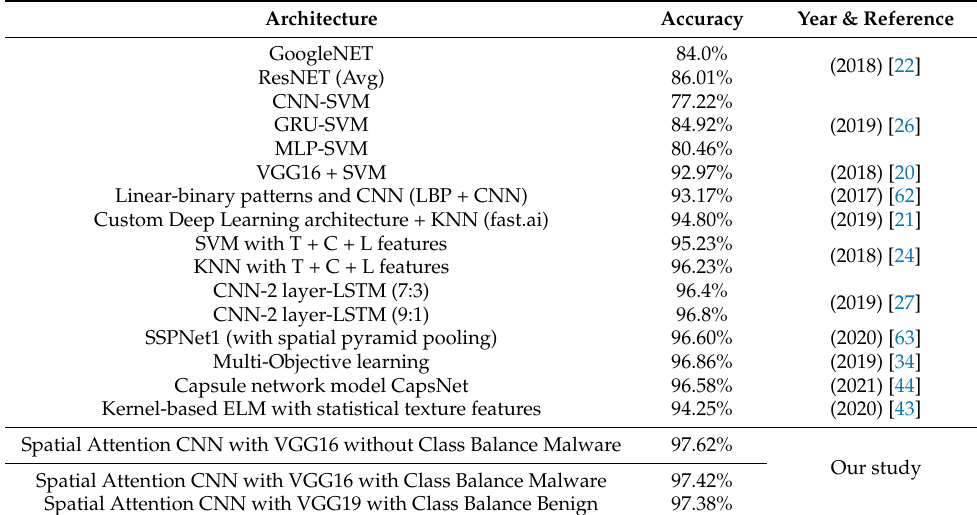
Table 4. Comparison of the proposed model with state-of-the-art